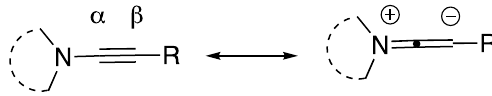
Figure 2. Polarization of the N -alkynyl azole triple bond.